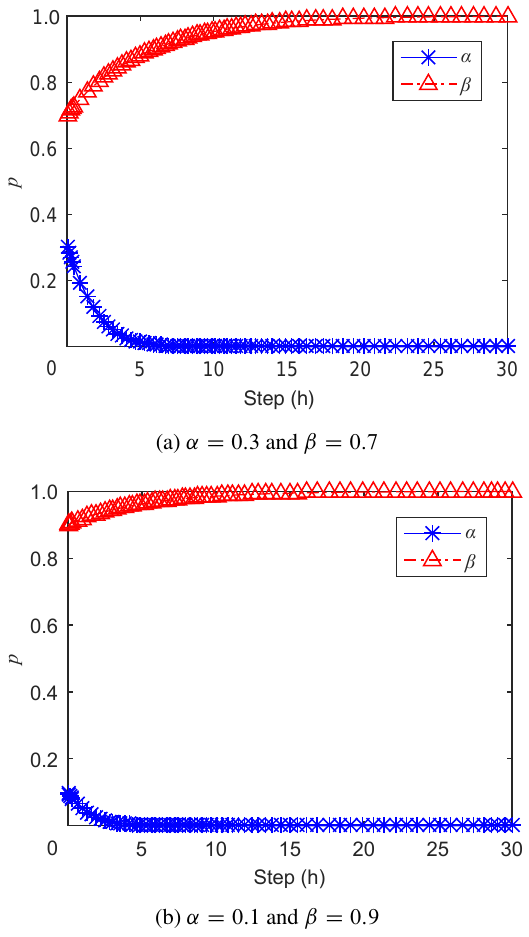
Fig. 2 Probability variation trend in the dissemination process of public opinion in Scenario